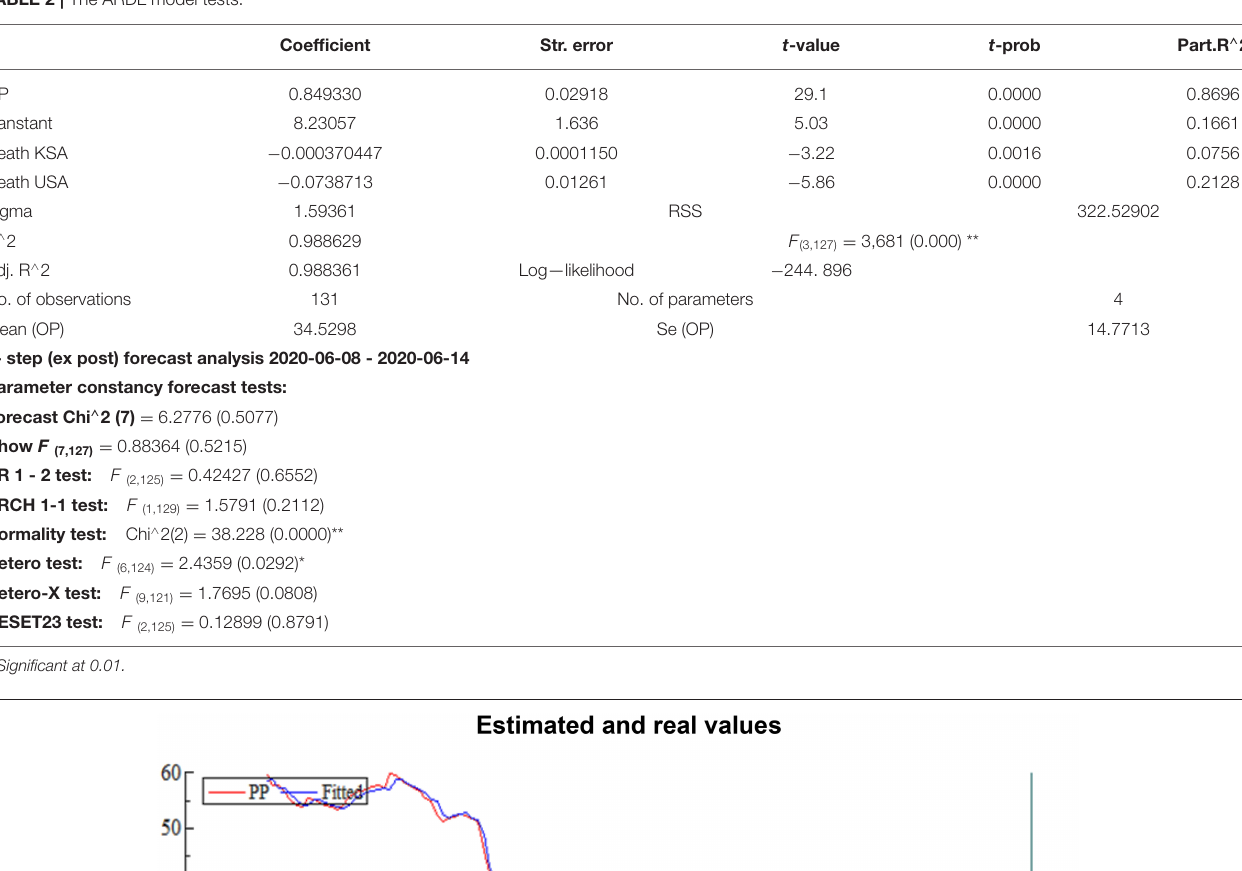
TABLE 2 | The ARDL model tests.